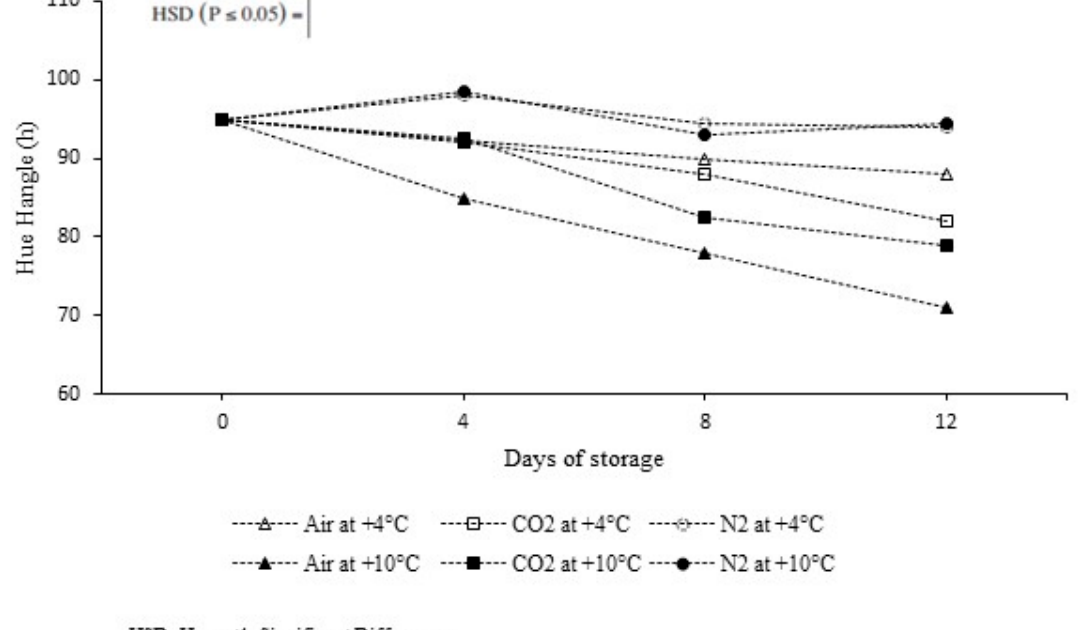
Figure 2. Hue angle (h) over 12 days of storage at +4 °C and +10 °C in air, 100 ± 1 kPa of CO 2 , and 100 ± 1 kPa of N 2 , respectively.